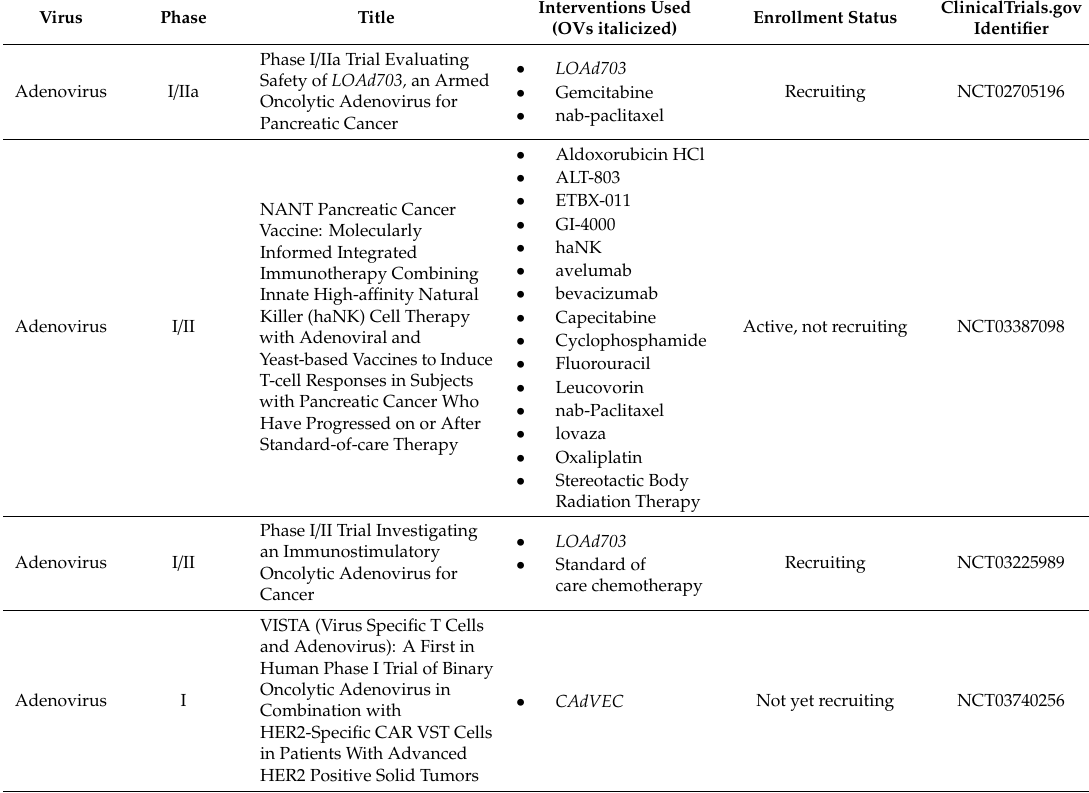
Table 2. A sampling of current clinical trials involving pancreatic cancer and oncolytic